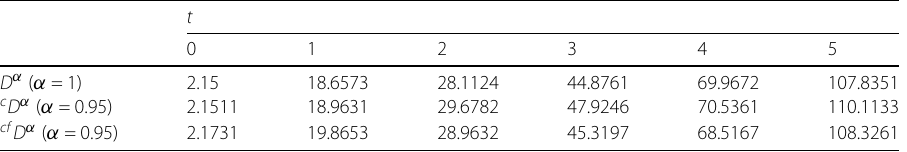
Table 5 Comparison between the standard derivative, Caputo fractional derivatives, and Caputo–Fabrizio fractional derivative for V ( t ) t 0 1 2 3 4 5 D α ( α =